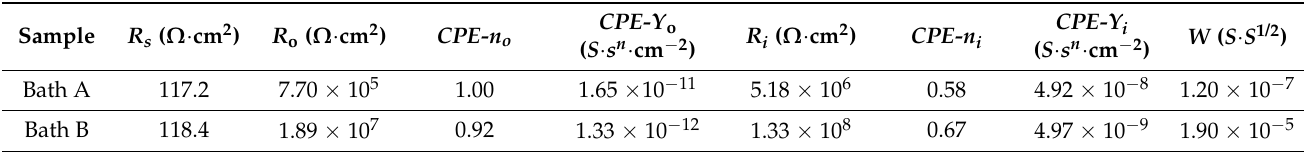
Table 2. Results of the EIS tests of PEO-coated samples immersed in 3.5 wt.% NaCl solution.